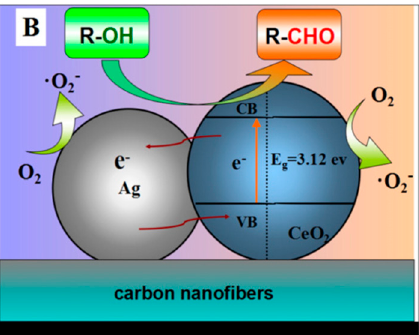
Figure 27. Schematic view of the proposed reaction mechanism over the CeO 2 /Ag@carbon nanofiber hybrids catalysts under visible light irradiation. Reprinted with permission from reference [186].